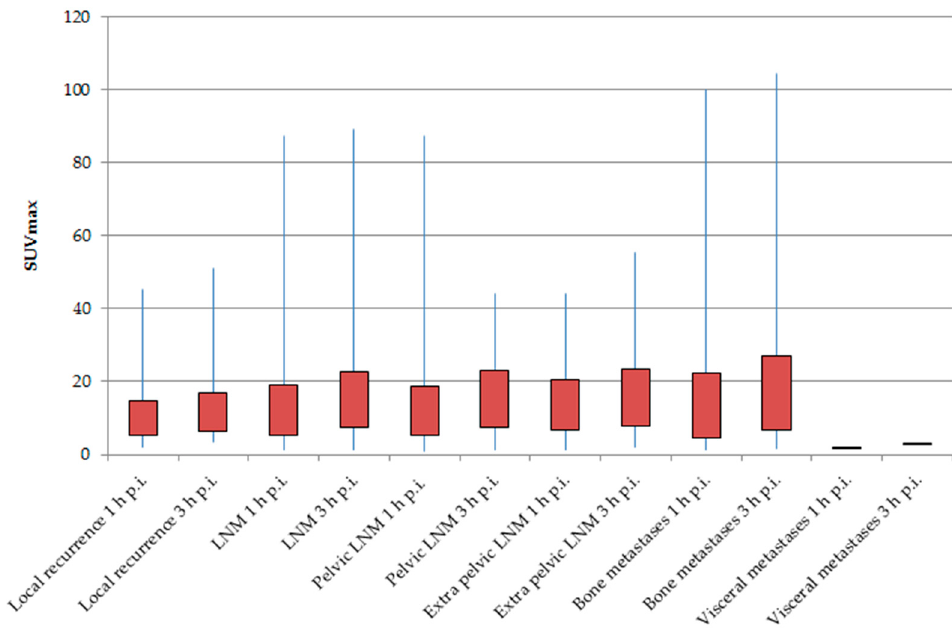
Figure 1. Flow chart showing baseline and delayed [ 68 Ga]Ga-PSMA-11 PET/CT results regarding LPR in patients.